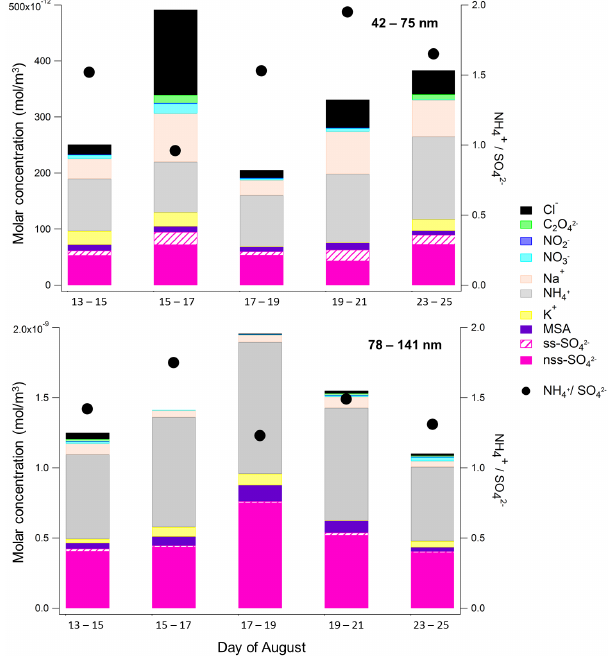
Figure 7. Average 2-day molar concentrations of ionic species present in 48–75nm (top) and 78–141nm (bottom) particles, as measured by the MOUDI/IC. The black circles represent the cor- responding NH + to SO 2 − molar ratios. Uncertainties in the ionic 4 4 species’ concentrations are ± 20%. The 2-day sampling period starts at noon (PDT) on the first day